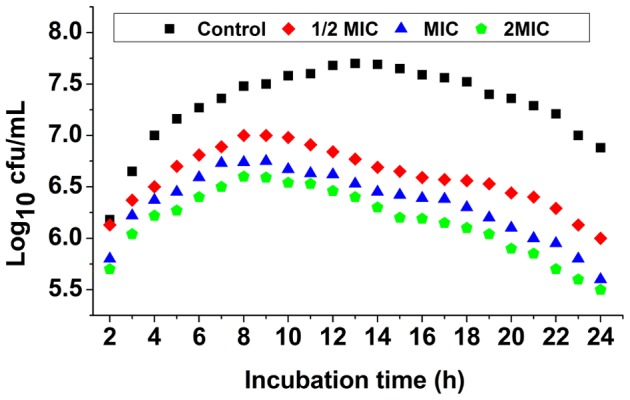
Growth curves of C. michiganense subsp. sepedonicum in the presence and absence of Fractionation three.MIC, Minimum inhibitory concentration.